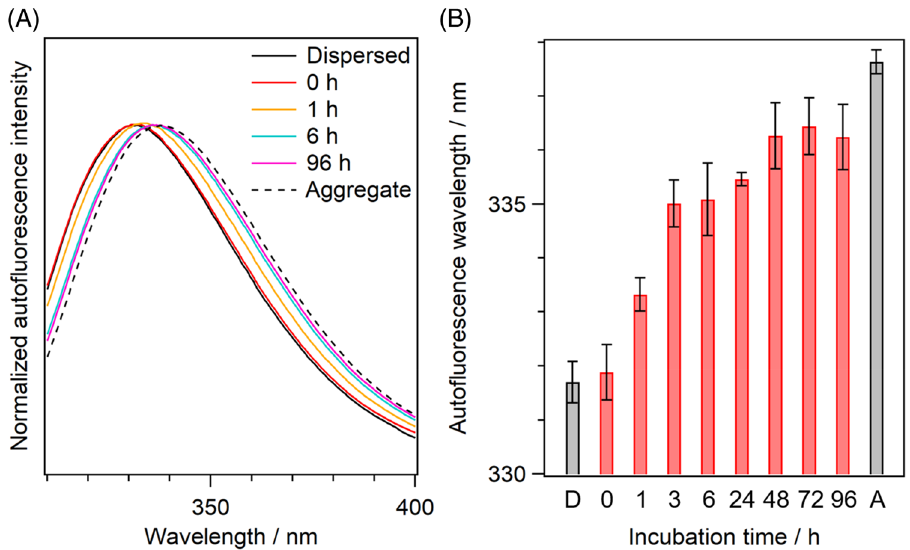
Figure 3. ( A ) Normalized autofluorescence spectra and ( B ) their peak wavelengths of Q28 in the dispersed solution, the droplets, and the aggregates. In ( A ), coloured solid curves are the autofluorescence spectra of the droplets at various incubation times. Black solid and broken curves are the autofluorescence spectra of the dispersed solution and the aggregates, respectively. In ( B ), red bars are the peak wavelengths of the droplets at various incubation times. Values below the bars are the incubation times in hours. “D” and “A” below the bars represent the dispersed solution and the aggregates, respectively. Error bars are SD (The numbers of replicates are summarized in Table